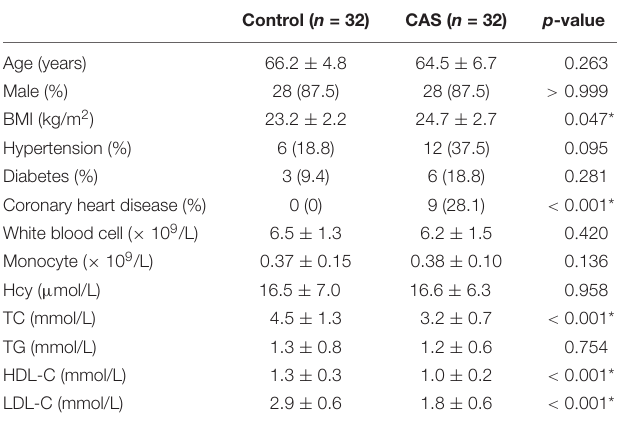
TABLE 1 | Characteristics of study